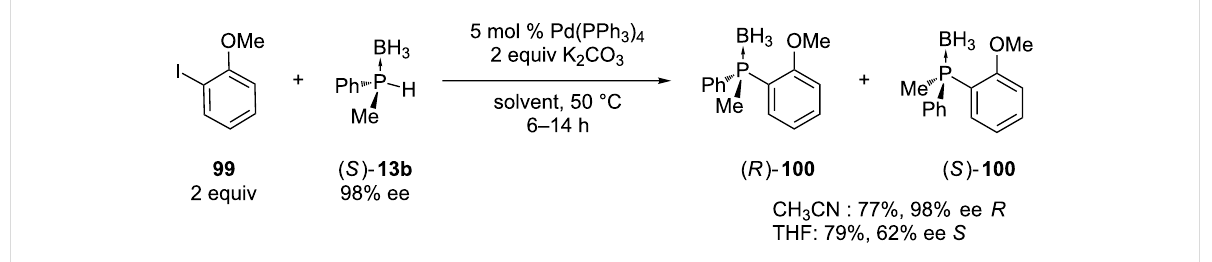
Scheme 28: Synthesis of optically active phosphine boranes 100 by cross-coupling with a chiral phosphine borane 13b